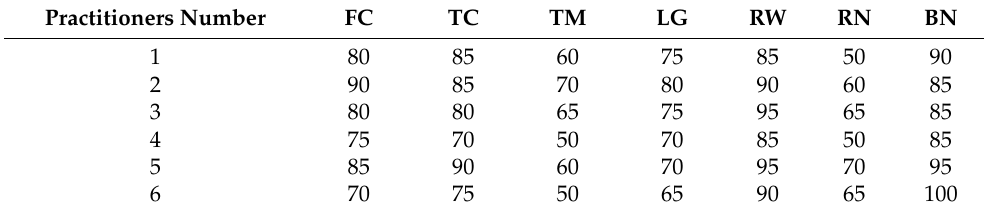
Table 4. The scores given by